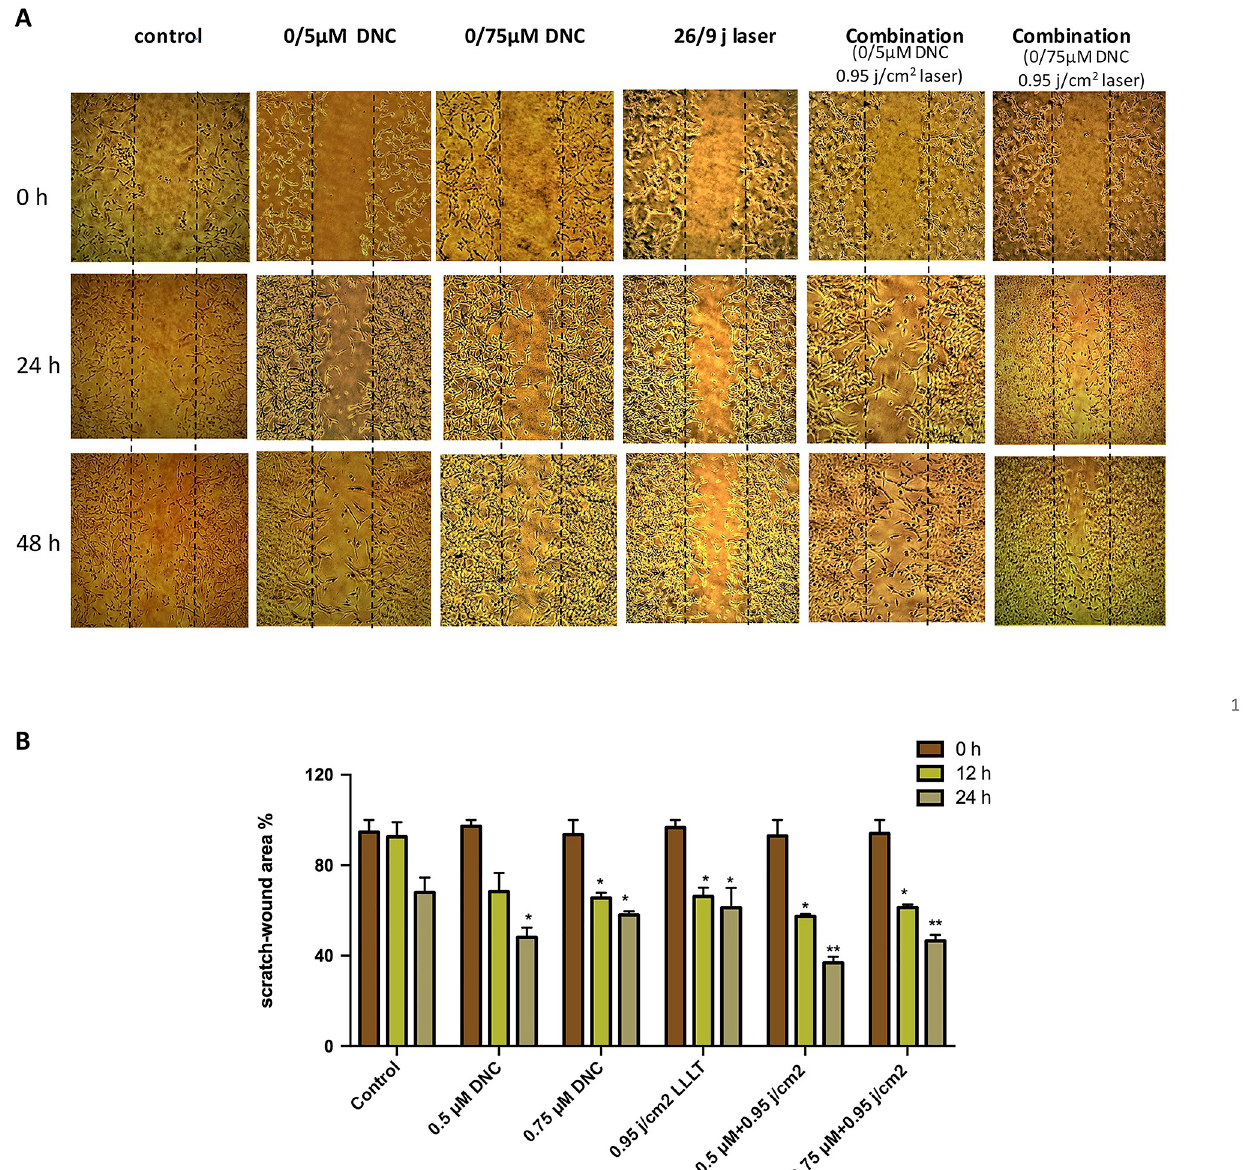
Fig 6. Migratory ability of MEFs 12 & 24h post treated with DNC and LLLT 450 nm and combination treatment. (A) Representative images (40 × magnification) from wound healing assay of MEFs treated with optimal doses of DNC, LLLT 450 nm and in combination at different time points (0, 12 and 24 h). Control groups were not treated. Cell migration into the cell-free region was marked by dotted lines at 0 hours (scale bar: 750 μ m). (B) Comparing the migrated percentage of MEFs with the cell-covered area at indicated time points using ImageJ software illustrates the wound healing rate represented in bar graph. Data are expressed as the mean ± SEM of triplicate experiments ( � : P < 0.05; �� : P <